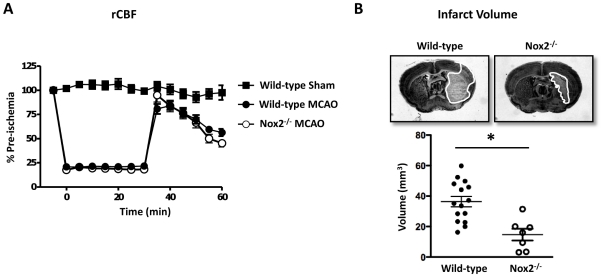
Effect of middle cerebral artery occlusion on cerebral blood flow and infarct volume.Regional cerebral blood flow (rCBF; n = 7 for sham, n = 60 for wild-type and n = 22 for Nox2-/-; A) and infarct volumes at 24 h following middle cerebral artery occlusion (MCAO; B) in wild-type and Nox2-deficient (Nox2-/-) mice. rCBF was measured during MCAO and during reperfusion (30 min). Representative (n = 15 for wild type and n = 7 for Nox2-/-) coronal brain sections are shown for wild-type and Nox2-/- mice at 24 h after MCAO with the infarct area outlined in white (B, top). All results are presented as mean±SEM. *P<0.05 vs. wild-type (unpaired t test).